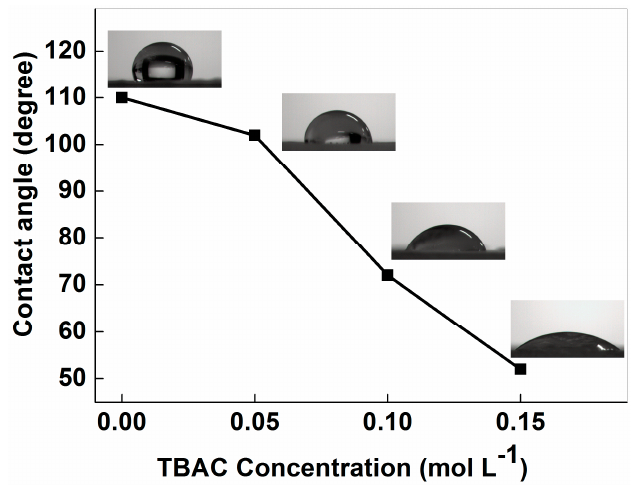
Figure 4. Contact angle of PVDF nanofiber membranes with different contents of TBAC. Table 1. Comparison of PVDF ‐ TLNM and various membranes prepared by the phase inversion method.